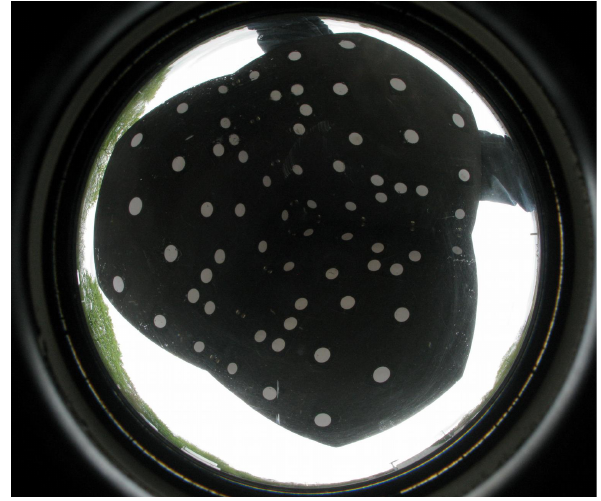
Figure 6. Camera calibration with cube: the pattern on the inside of the cube defines a set of 3-D points with respect to the cube co- ordinate system and can be used as reference data to solve for the fisheye projection